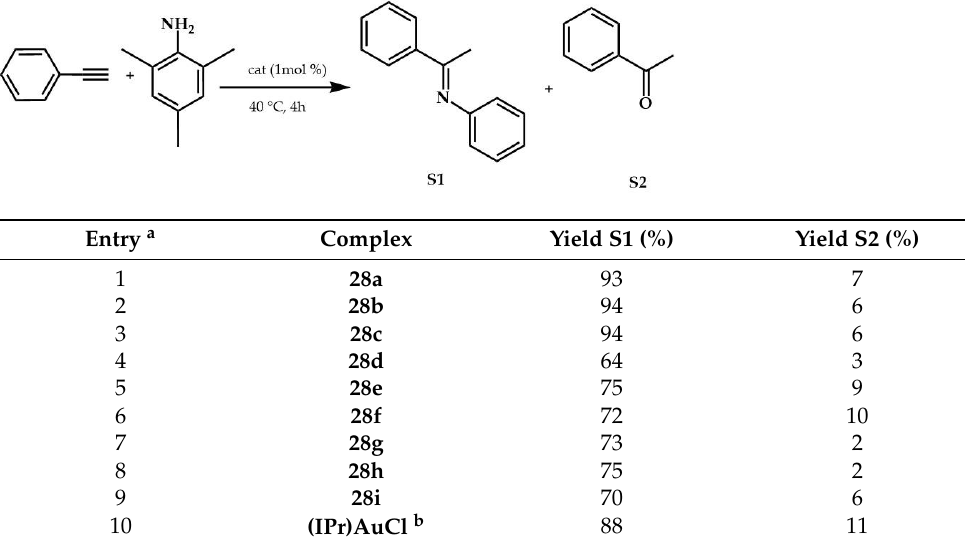
Figure 13 . Gold(I) diNHC complexes Au 2 Br 2 L 1 − 9 of Baron et al. [29]. Single-crystal X-ray diffraction analyses have been made for Au 2 Br 2 L 4 , Au 2 Br 2 L 5 , and Au 2 Br 2 L 6 . The authors used 28i complex to optimize the reaction conditions of hydroamination of phenylacetylene with 2,4,6-trimethylaniline. The best reaction conditions found were neat conditions, 4 h and 2 mol% AgSbF 6 as co-catalyst. The results are reported in Table 11. The catalytic activity of synthesized Au 2 Br 2 L 1 − 9 complexes was compared with that of the benchmark (IPr)AuCl complex. Better performances were recorded with the N-methyl-substituted complexes ( 28a – c ), which, together with benchmark (IPr)AuCl, reached complete alkyne conversions and very high hydroamination yields within the 4 h reaction time. Table 11. Hydroamination reaction of phenylacetylene with 2,4,6-trimethylaniline .